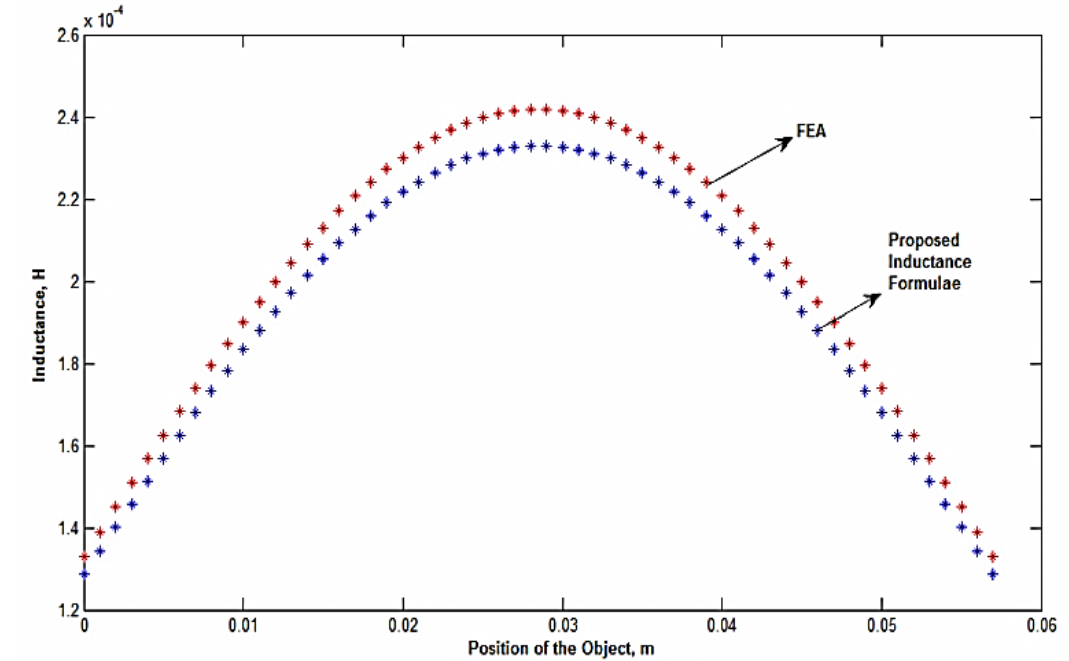
Figure 8. Inductance profile of a single coil of